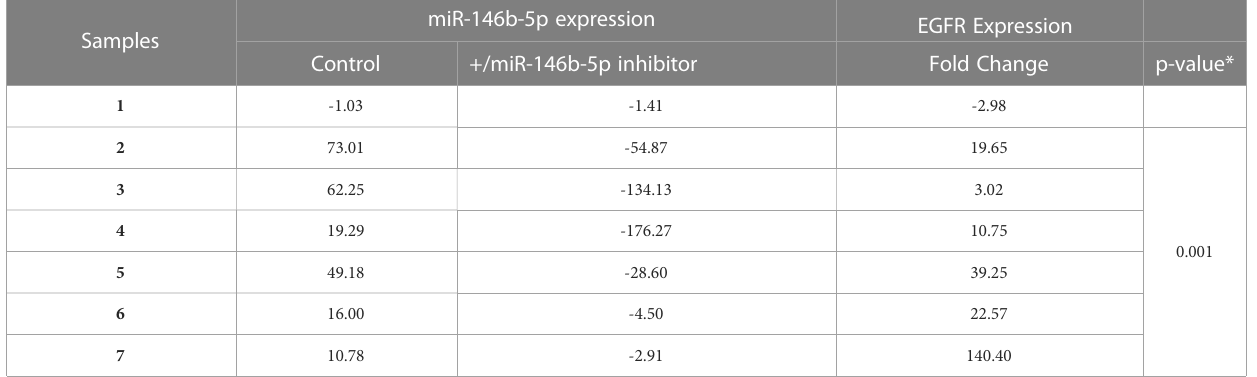
TABLE 3 Effect of miR-146b-5p inhibitor on EGFR mRNA expression in PTC.